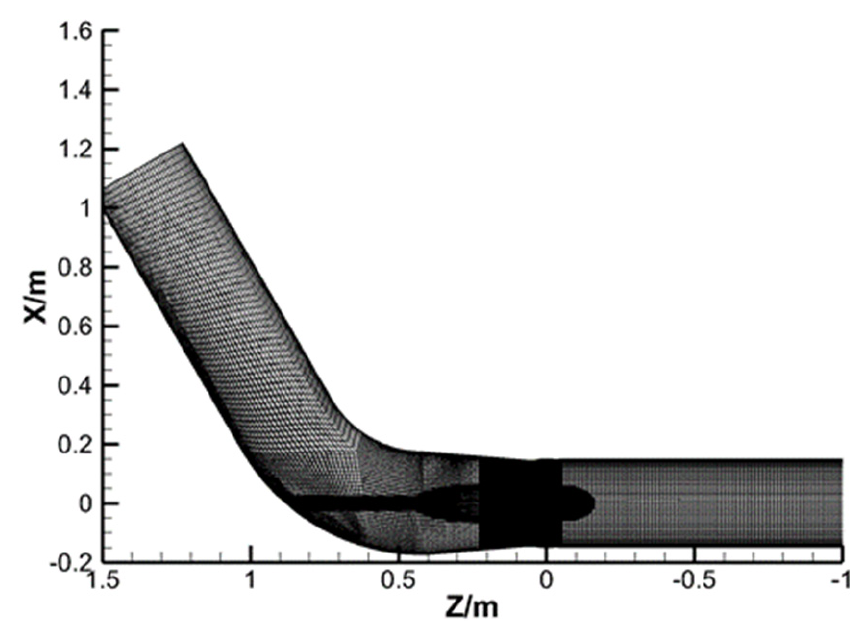
Figure 3. Overall size and grid of pump section.